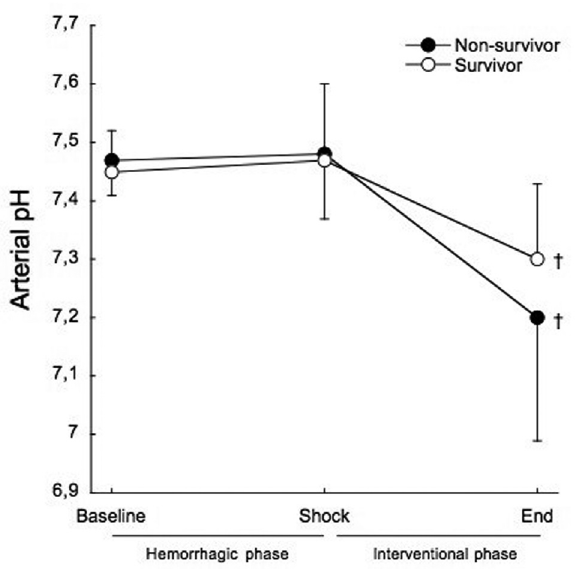
Figure 4 - Mean arterial pH before treatment at hemorrhagic phase (baseline and shock), and after treatment at the end of the interventional phase, in survivors (open circles) and non-survivors (filled circles). † p <0.001 when compared to baseline.